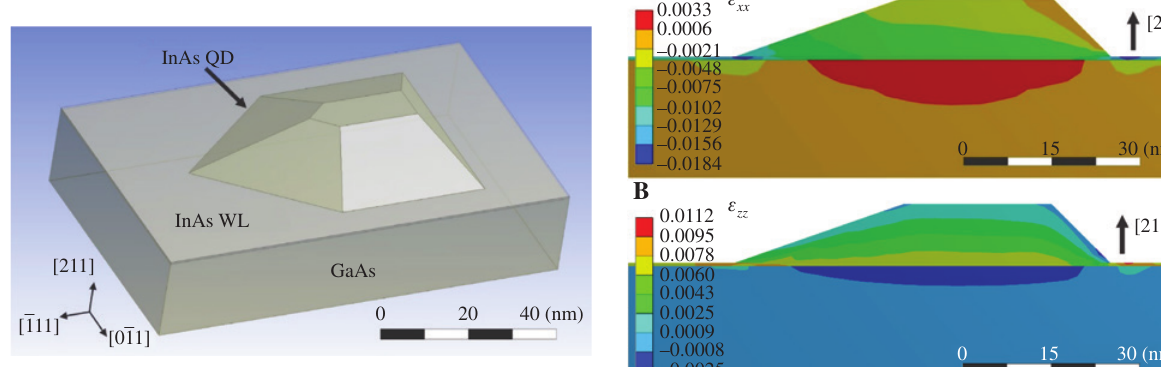
Figure 2: FE simulation of the (A) in-plane ε residual elastic strain components of an uncapped InAs QD grown on GaAs (211)B, assuming that the QDs are under plane